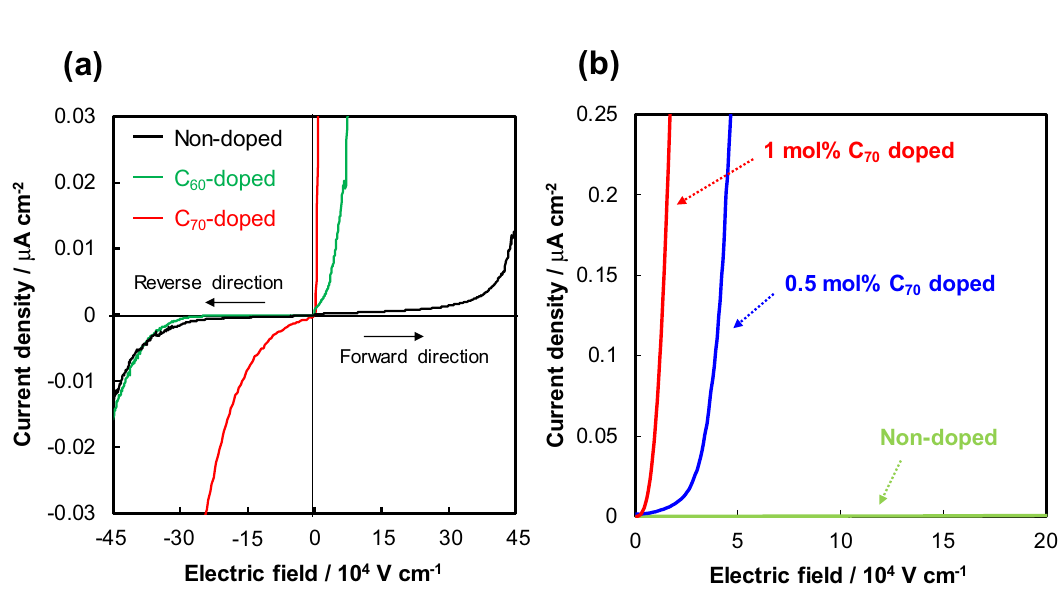
Figure 2. J - E characteristics at room temperature of the Au/fullerene-doped TPA/TPA/Au layered devices ( a ) in forward and reverse directions when 1 mol% C 60 and C 70 was doped, and ( b ) as a function of C 70 doping amount in forward